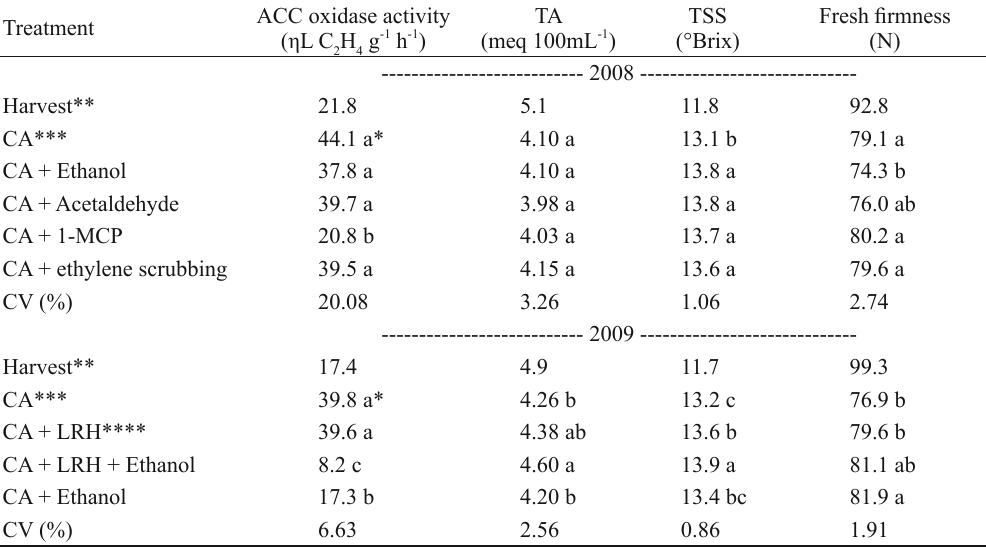
ACC oxidase activity, titratable acidity (TA), total soluble solids (TSS) and fl esh fi rmness of ‘Royal Gala’ apples stored in controlled atmosphere for eight months and then exposed for seven days at 20 °C. Santa Maria, 2008 and